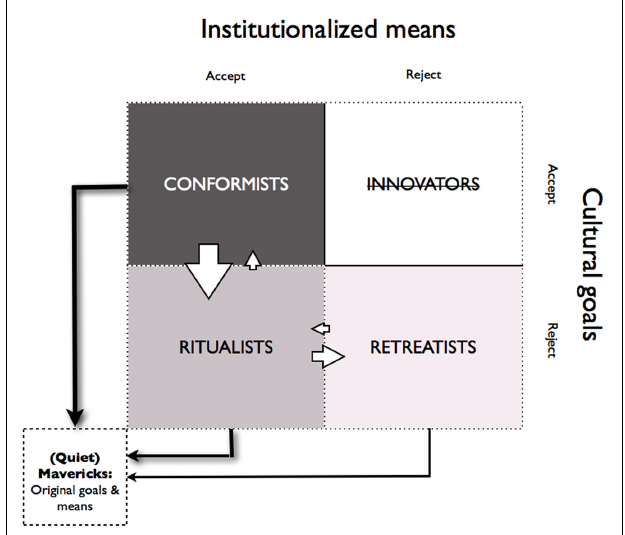
FIGURE 2 |The predicted flow of young people between adaptive categories in globalizing conformist societies such as